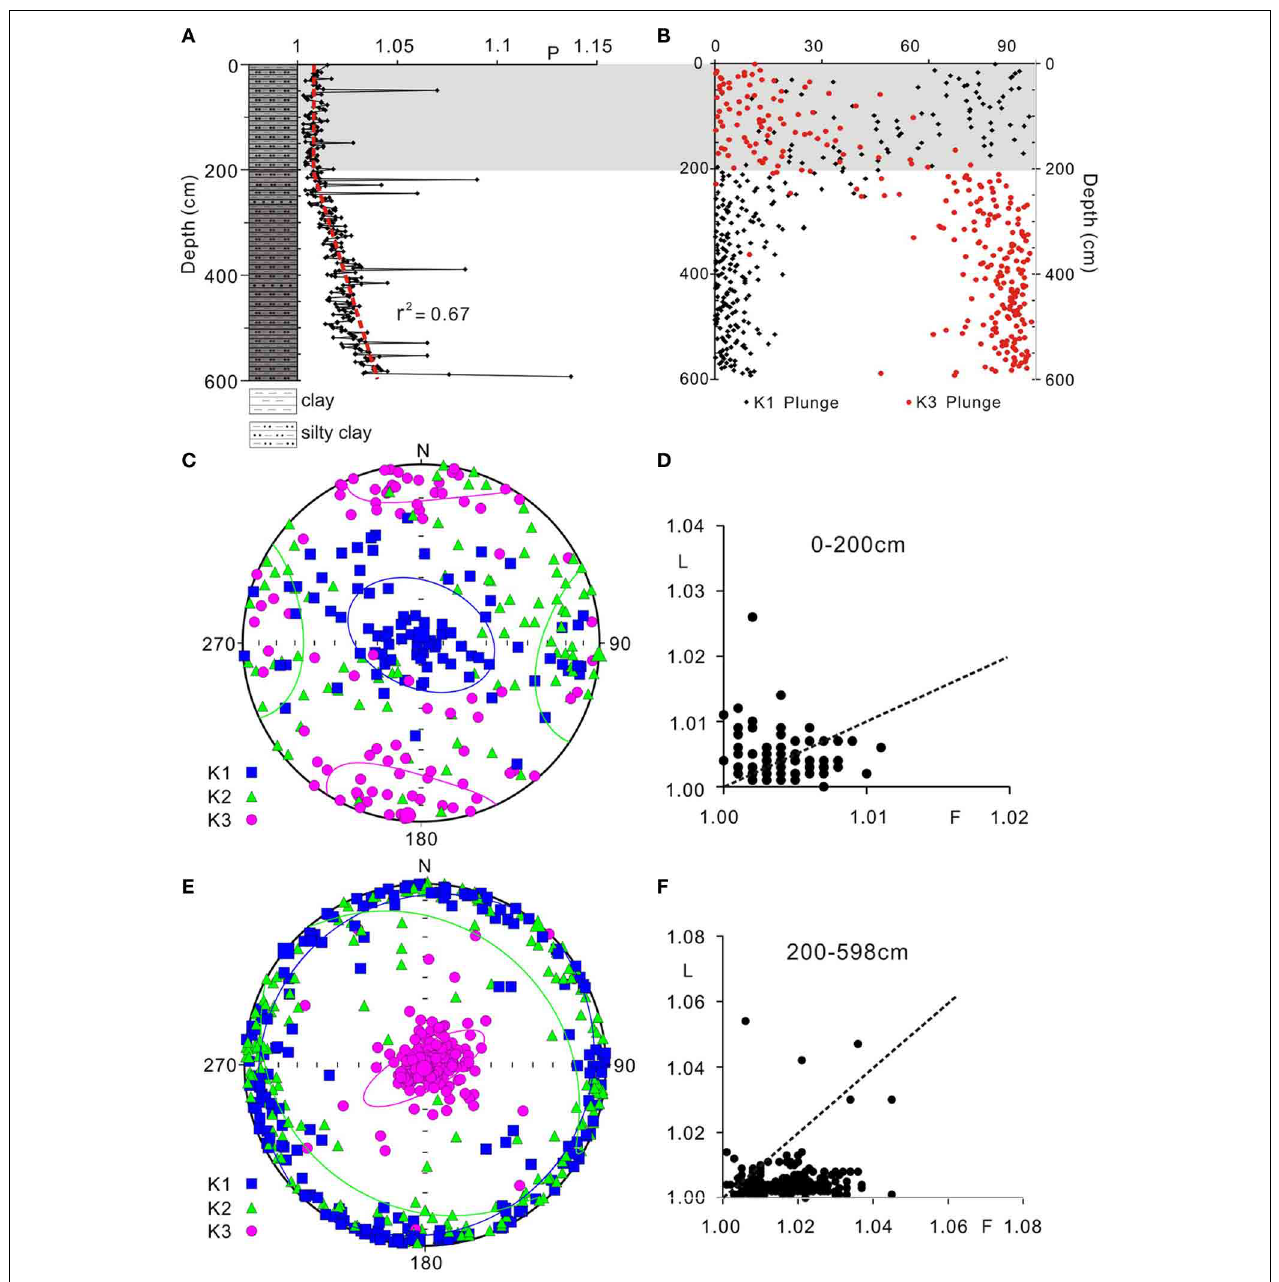
FIGURE 2 | Down-core changes in composition and anisotropy of magnetic susceptibility (AMS) of Core GHE24L. The core consists mainly of light gray to gray clays and silty clays (A) . The upper 2m sediments display a weak triaxial fabrics ( B–D) with the intensity of anisotropy around 1.01 (A) . The > 2m sediments show well-defined